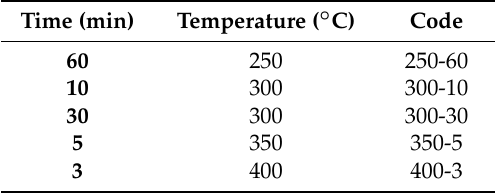
Table 1. Time-temperature regimes used in